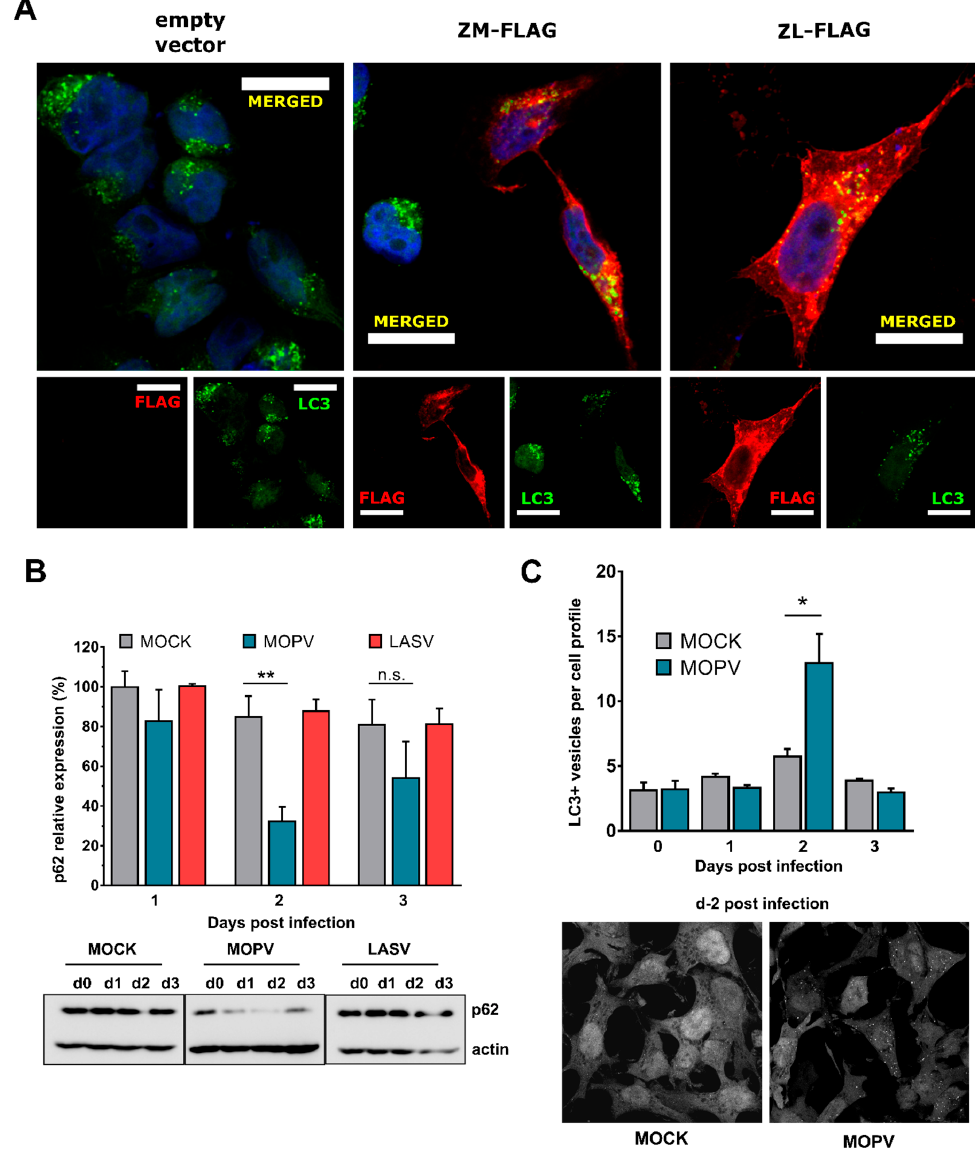
Figure 3. MOPV, but not LASV, induces transient autophagy in HeLa cells. ( A ) GFP-LC3 HeLa cells were treated for 2 h with CQ at a final concentration of 50 µM before transfection with the indicated plasmids for 15 h. Cells were then fixed and stained with a primary mouse anti-FLAG antibody and a secondary anti-mouse coupled Alexa555 antibody before observation by confocal microscopy ( n = 3 independent experiments). All images were acquired using a confocal Zeiss LSM 510 microscope with an Axioscope 63× oil immersion lens objective. The scale bar represents 20 µm. ( B ) HeLa cells were mock infected or infected with LASV or MOPV at an MOI of 2. Cells were harvested at the indicated timepoints for p62 analysis by Western blotting. The graph represents the intensity of p62 over actin expression normalized to the MOCK-infected condition at d0 (not represented on the graph). The error bars represent the standard error of the means from five and four independent experiments for MOPV and LASV, respectively. * p < 0.05, ** p < 0.01, and n.s.: non-significant, as determined by a Student’s t -test. ( C ) GFP-LC3 HeLa cells were infected with MOPV at an MOI of 2 for the indicated times and fixed for confocal microscopy analysis. The images were acquired using the same microscope as in (A) with an Axioscope 63 × oil immersion lens objective. The error bars represent the standard error of the means from three independent experiments, * p < 0.05, as determined by a Student’s t -test. GFP-LC3 dots were counted in 50 cells per